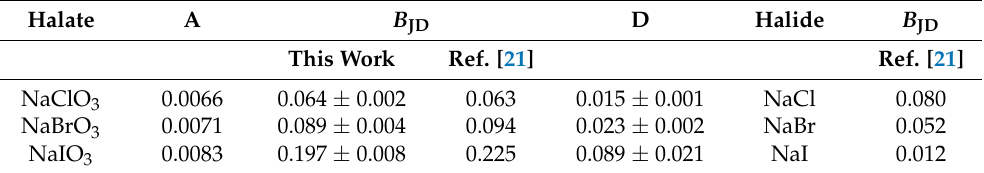
Figure 2. Extended Jones-Dole (Equation (A8)) fitting for sodium chlorate (black), bromate (blue), and iodate (red) solutions. The inset shows the values in the entire range of concentrations for sodium chlorate. Table 2. A (in mol − 1/2 · L 1/2 ), B JD (in mol − 1 · L), and D (in mol − 3/2 · L 3/2 ) coefficients obtained by fitting the data with Equation (A8). The B JD values are compared with those reported by Ref. [21] and with those of sodium halide [21].